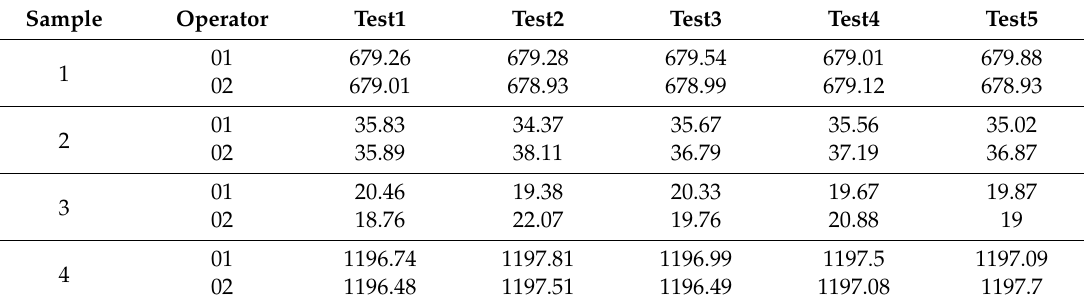
Table 7. Raw data for the maximum bending force from the intra-laboratory experiment.